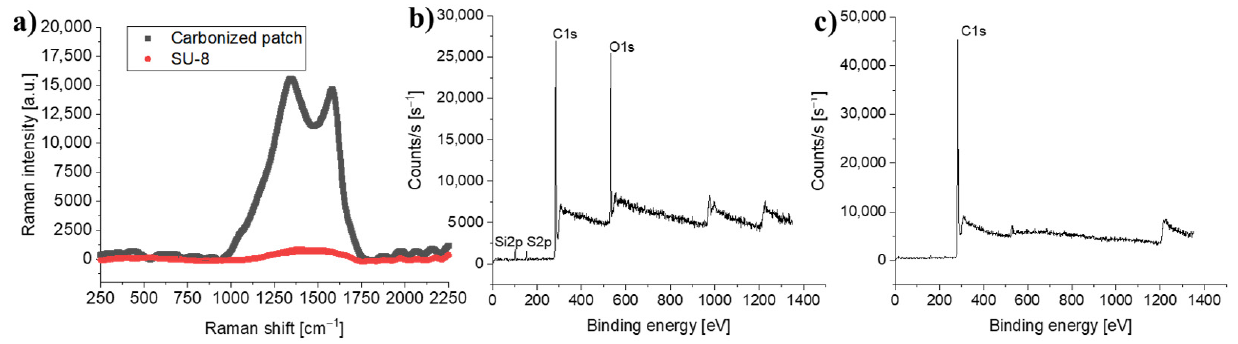
Figure 4. ( a ) Raman spectra of SU-8 ( red ) and laser-pyrolyzed carbon ( black ). The thickness of the lines corresponds to the standard deviation ( n = 3). ( b ) XPS analysis of the surface of a carbonized line. ( c ) XPS analysis of a carbonized line after 45 s of ion milling.